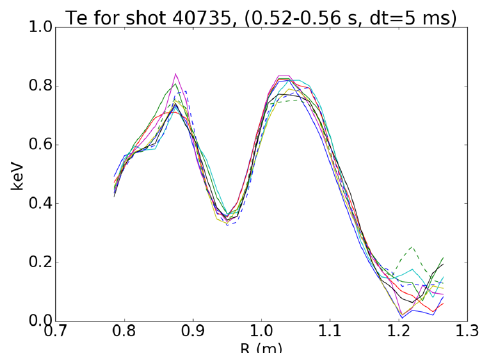
Fig. 14. Electron temperature profiles at different times during the Type 7 emissions of shot #40735, as reconstructed by the Michelson Interferometer. The regions at major radius R=0.83 m and R=1.08 m are perturbed (flattened) by the presence of a m:n=3:1 MHD magnetic island.